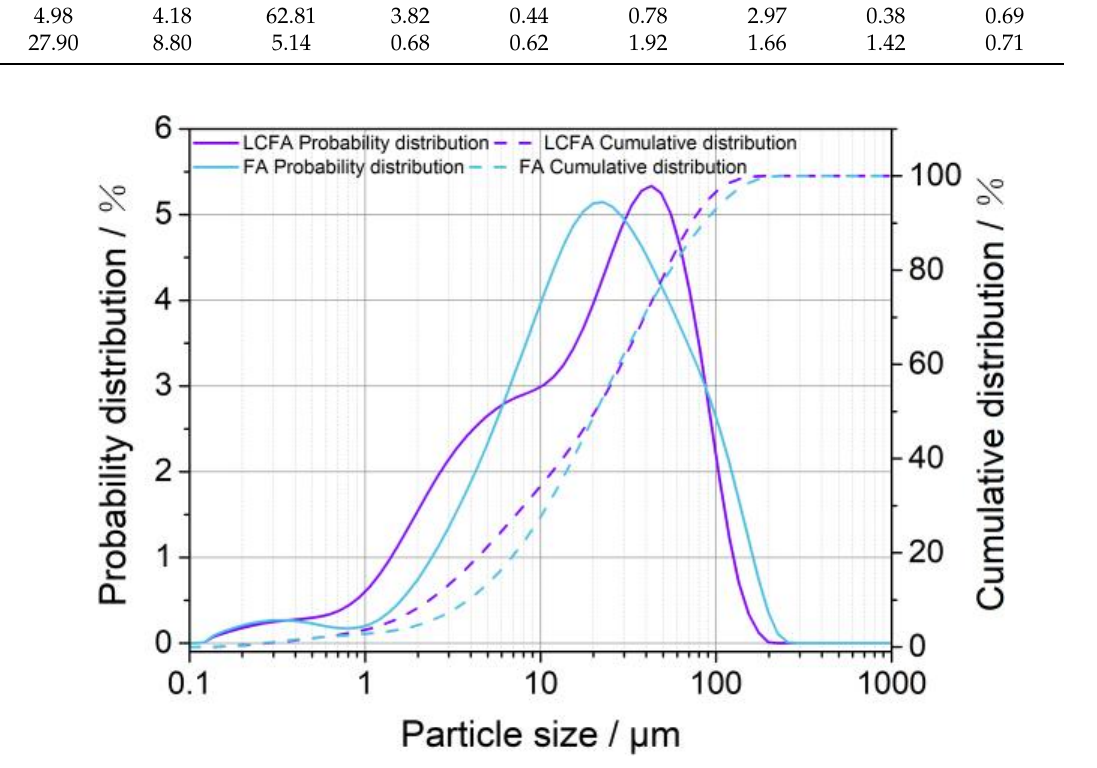
Figure 1. Probability distribution and cumulative particle size distribution of LCFA and FA.